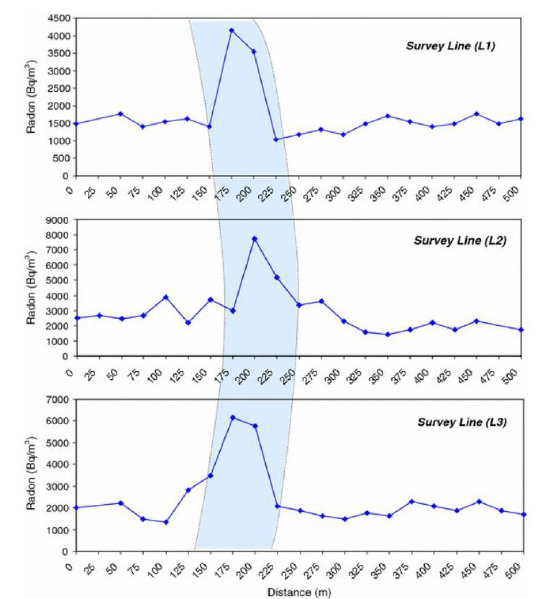
Figure 21. The tectonic zone (crack zone) detected by emanometry. The zone is manifested like radon anomaly. By Mohamed Al-Hilal, Syria.